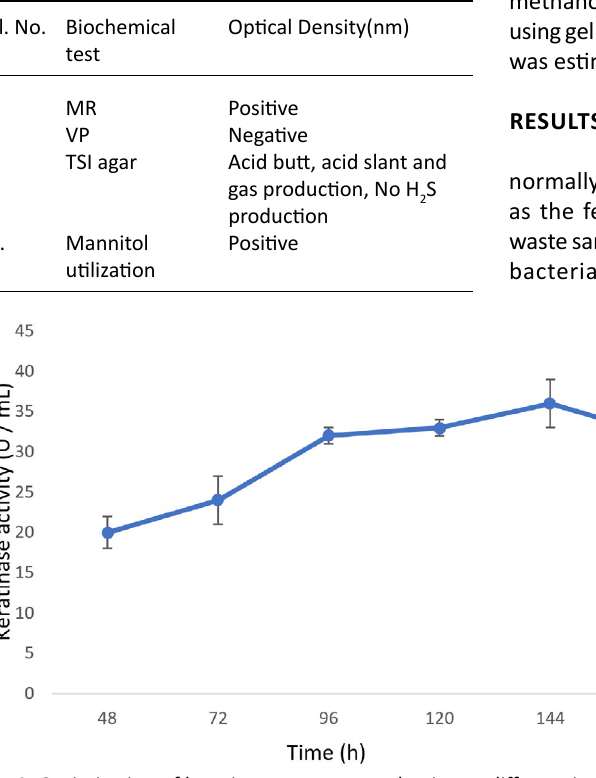
Fig. 1. Optimization of keratinase enzyme production at different incubation